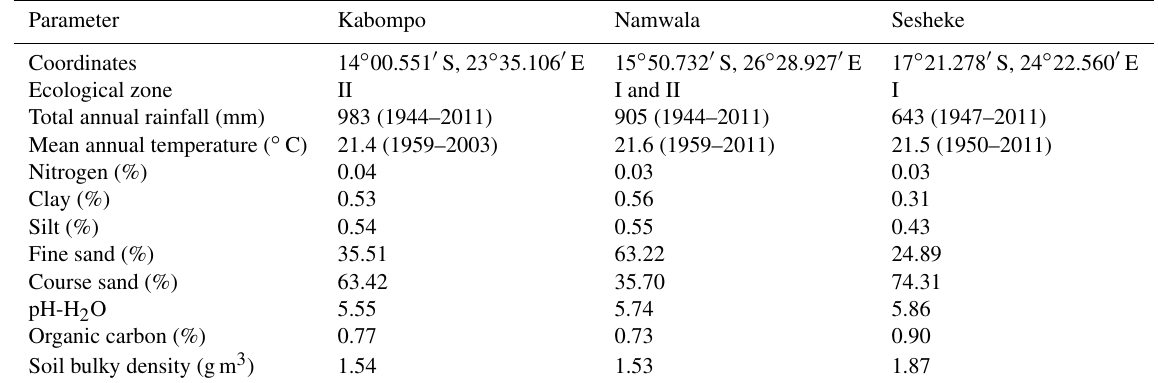
Table 1. Climate and soil characteristics at Kabompo, Namwala, and Sesheke. For rainfall and temperature, the period covered for average values presented is given in